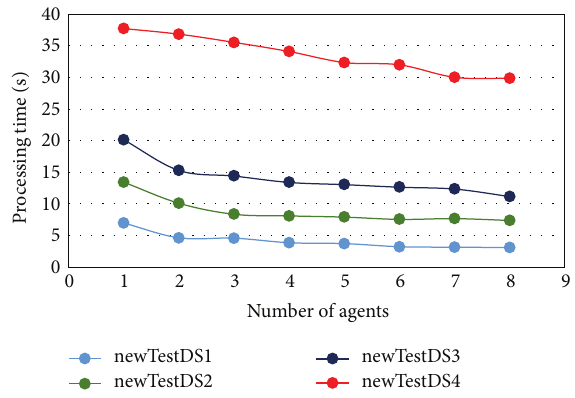
Figure 11:Comparison ofMAS-IDS processing timewith that of the nonagents hybrid modified 𝐾 -means and C4.5.